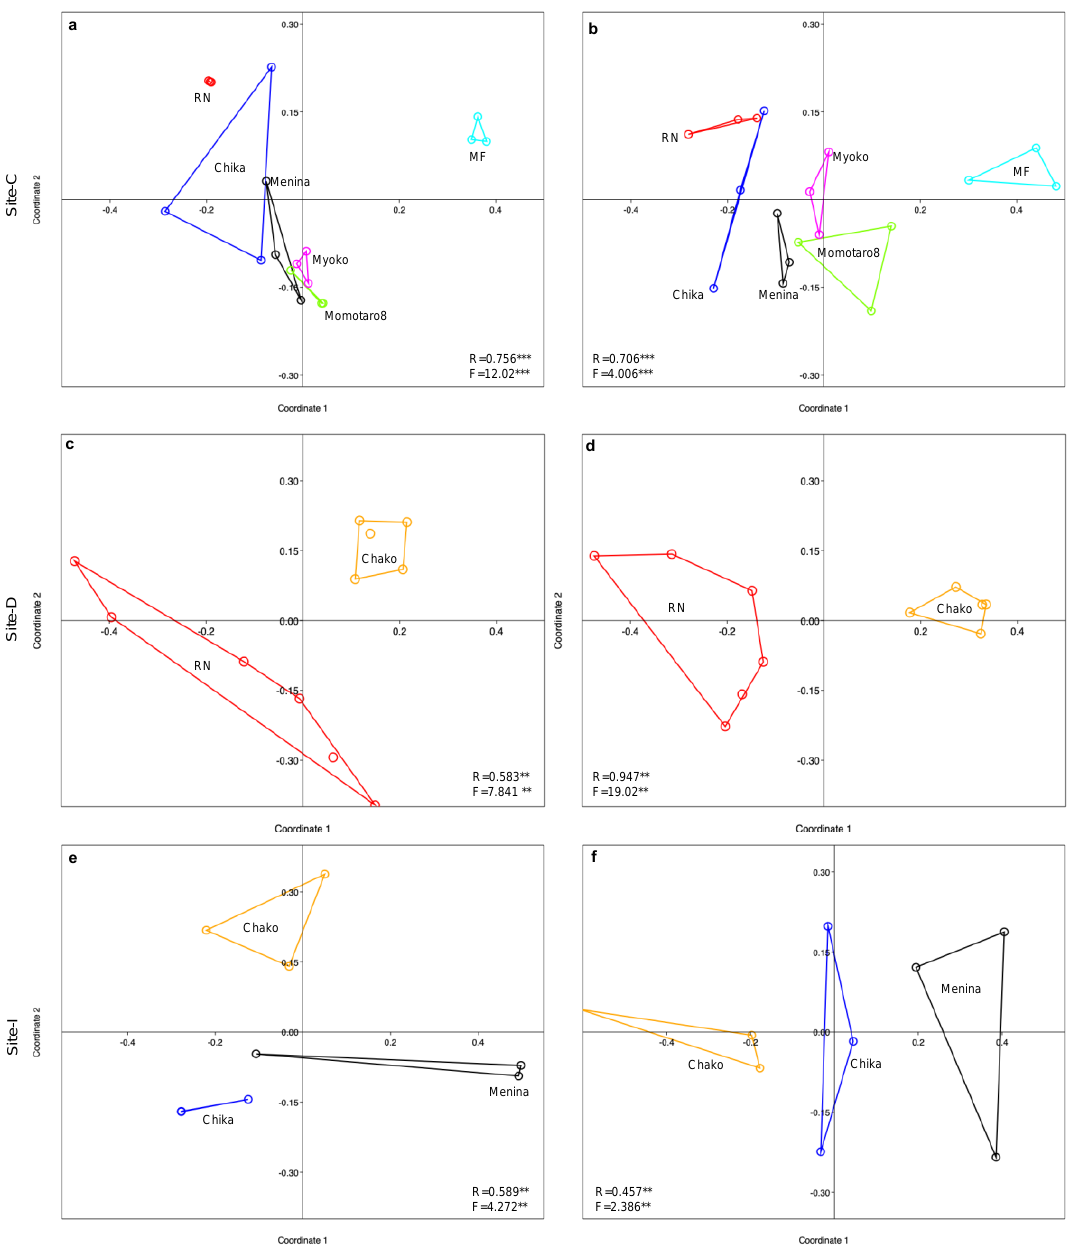
Figure 7. Fungal endophyte communities as influenced by host cultivars. Nonmetric multidimensional scaling (NMDS), one-way ANOSIM and one-way PERMANOVA analyses of endophyte communities recovered from several tomato cultivars as indicated by colors and labels at di ff erent locations in Japan. For clustering analysis, two di ff erent community similarity indices were computed: ( a , c , e ) Bray–Curtis coe ffi cient, which compares fungal taxa presence or absence along with the abundance among groups, and ( b , d , f ) Jaccard’s index uses only presence and absence data for comparing fungal community similarity among groups. The ANOSIM statistic R values; large positive R (up to 1) signifies dissimilarity between groups. F indicates the pseudo-F values. *** and ** represent the significance of dissimilarity ( R ) at p < 0.001 and p < 0.01, respectively, obtained by permutation of group membership, with 9999 replicates. RN = Rosso Neapolitan, MF = Mountain Fresh